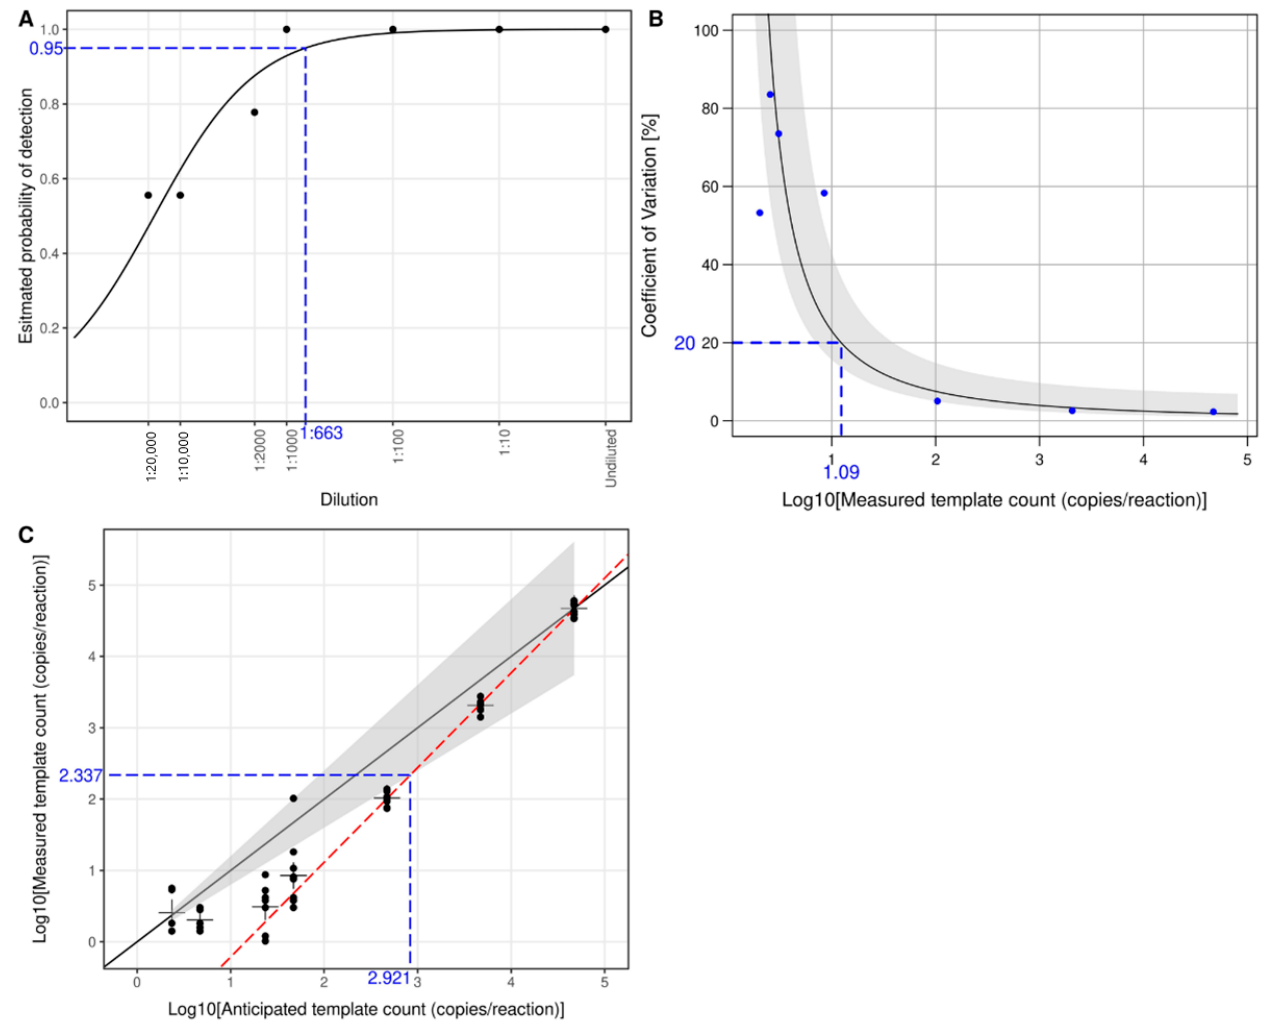
Figure 3. LLOD95 and LLOQ of RT-ddPCR for detection and quantification of DENV RNA. ( A ) LLOD95 was estimated by fitting a logistic regression model with detection results. Each dot indicates an actual detection rate at each dilution. The dashed horizontal line indicates 95% probability, and the dashed vertical line indicates an estimated dilution of 1:663 as LLOD95. LLOQ was determined by estimating %CV and comparing anticipated template counts to measured counts. ( B ) A precision profile shows a curve of estimated %CV and their corresponding confidence intervals (gray area). Each dot shows an actual %CV from measurements at the corresponding template count. The dashed horizontal line indicates a cut-off of %CV at ≤ 20%, and the dashed vertical line indicates a corresponding estimated template count of 1.090 log10- copies/reaction. ( C ) A comparison between anticipated and measured template counts shows measurement errors of RT-ddPCR. The solid diagonal line shows a perfect agreement, and the surrounding gray area indicates an acceptable error range of ± 20% of the anticipated count. Each dot shows a measured template count at a corresponding anticipated count, and the “+” signs indicate average measured template counts. A linear regression analysis (red dashed line) using measured counts above LLOD95 is plotted against estimated LLOQ. The dashed horizontal line indicates an estimated LLOQ of 2.337 log10-copies/reaction, and the dashed vertical line indicates a corresponding anticipated template count of 2.921